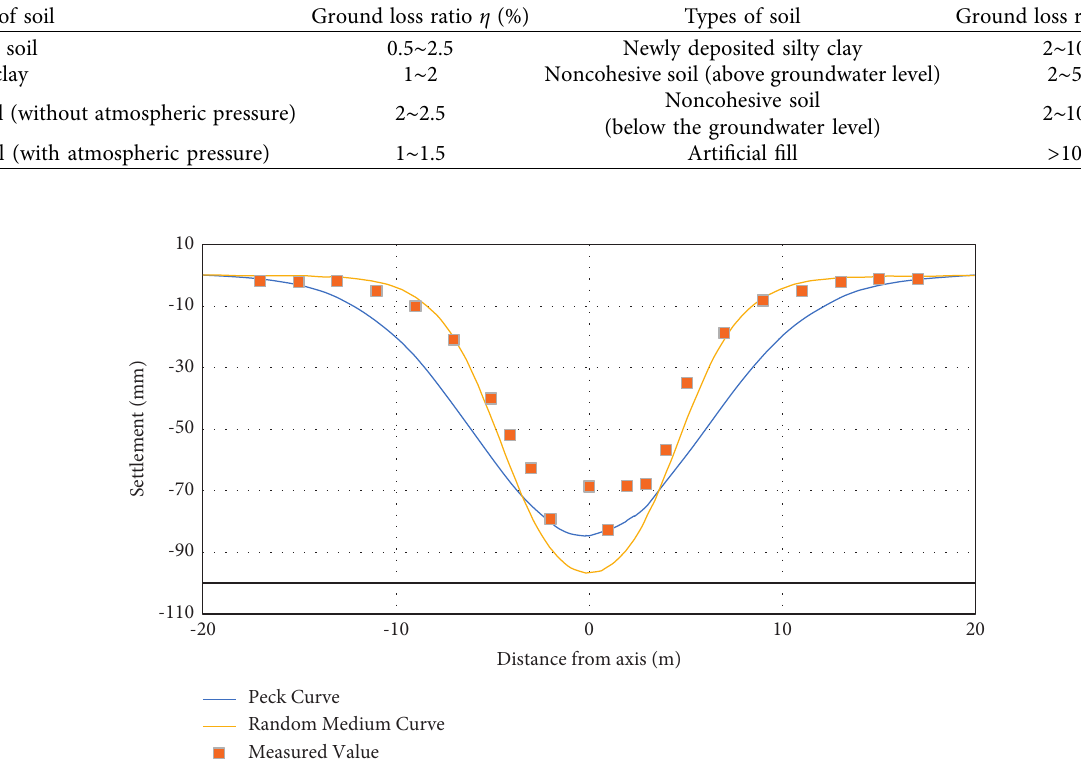
Figure 18: Comparison between calculated and observed results of CJ3’s